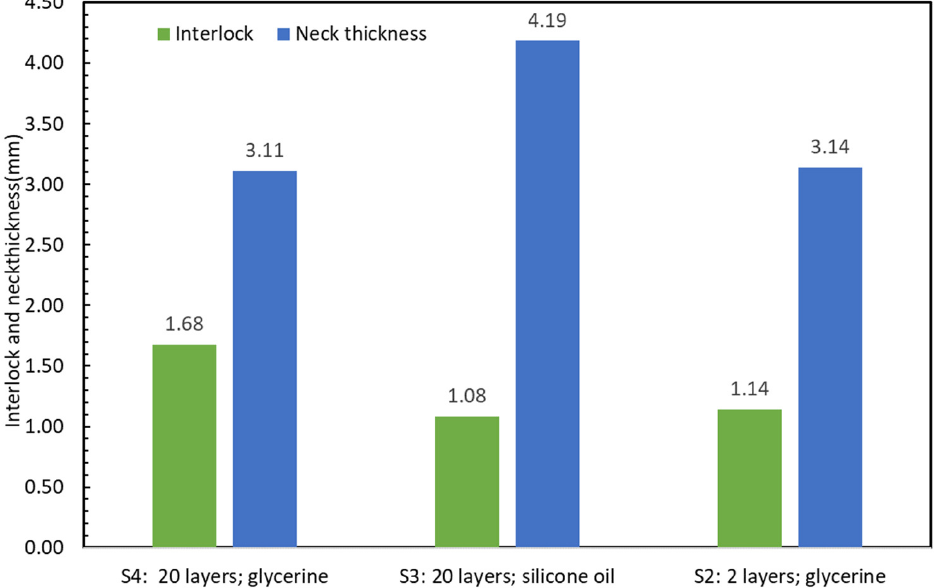
Figure 13. Comparison of interlock and neck thickness between experiments S2, S3 and S4.